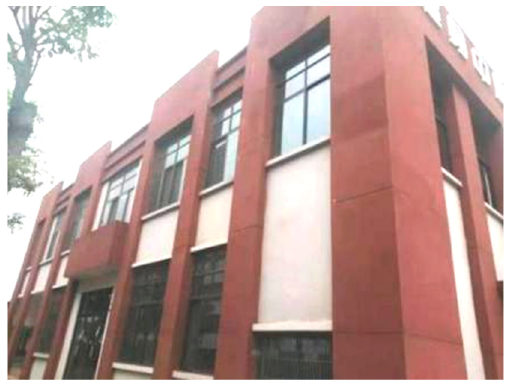
Figure 2. Research Area.